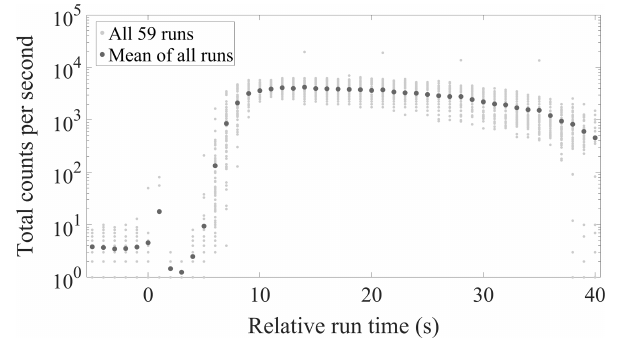
Figure 6. The data points show event temperatures of all ice crys- tals measured with PINE-1A during the same operation of 59 runs shown in Figs. 4 and 5. The events are plotted as a function of the relative run time at which they were detected, and the gas tempera- tures were measured at the same time with three sensors located in the lower (blue), the middle (green) and the upper (red) part of the